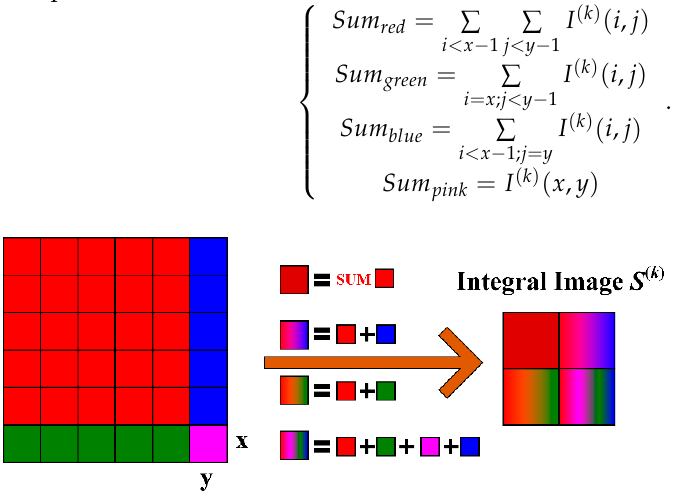
Figure 2. The flow chart of binarization algorithm.